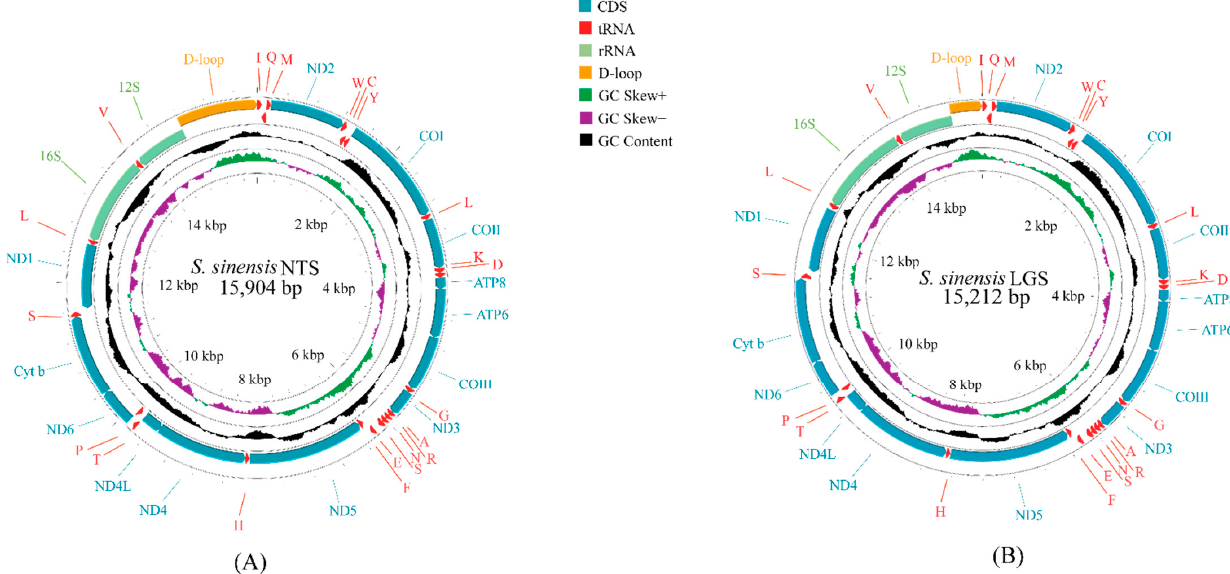
Figure 1. The mt genome maps of S. chinensis NTS ( A ) and S. chinensis LGS ( B ). The first circle represents the gene order. External genes are encoded by the positive strand, in contrast to the internal genes that are encoded by the negative strand. The second circle indicates the GC skew, and the third circle shows the GC content. Table 1. Composition of the mt genomes of S. chinensis NTS and S. chinensis LGS. The AT skew, GC skew and A + T content of corresponding regions (whole genome, PCGs, rRNAs and tRNAs) of S. chinensis NTS and S. chinensis LGS were calculated and are shown in Table 1. The nucleotide composition of the S. chinensis NTS mt genome was Region Strand Length AT% AT Skew GC Skew A = 33.7%, T = 32.1%, C = 19.9% and G = 14.3%, which was very similar to that of S. chinensis LGS (A = 34.0%, T = 32.6%, C = 19.4% and G = 14.1%). Both the whole genome of S. chinensis